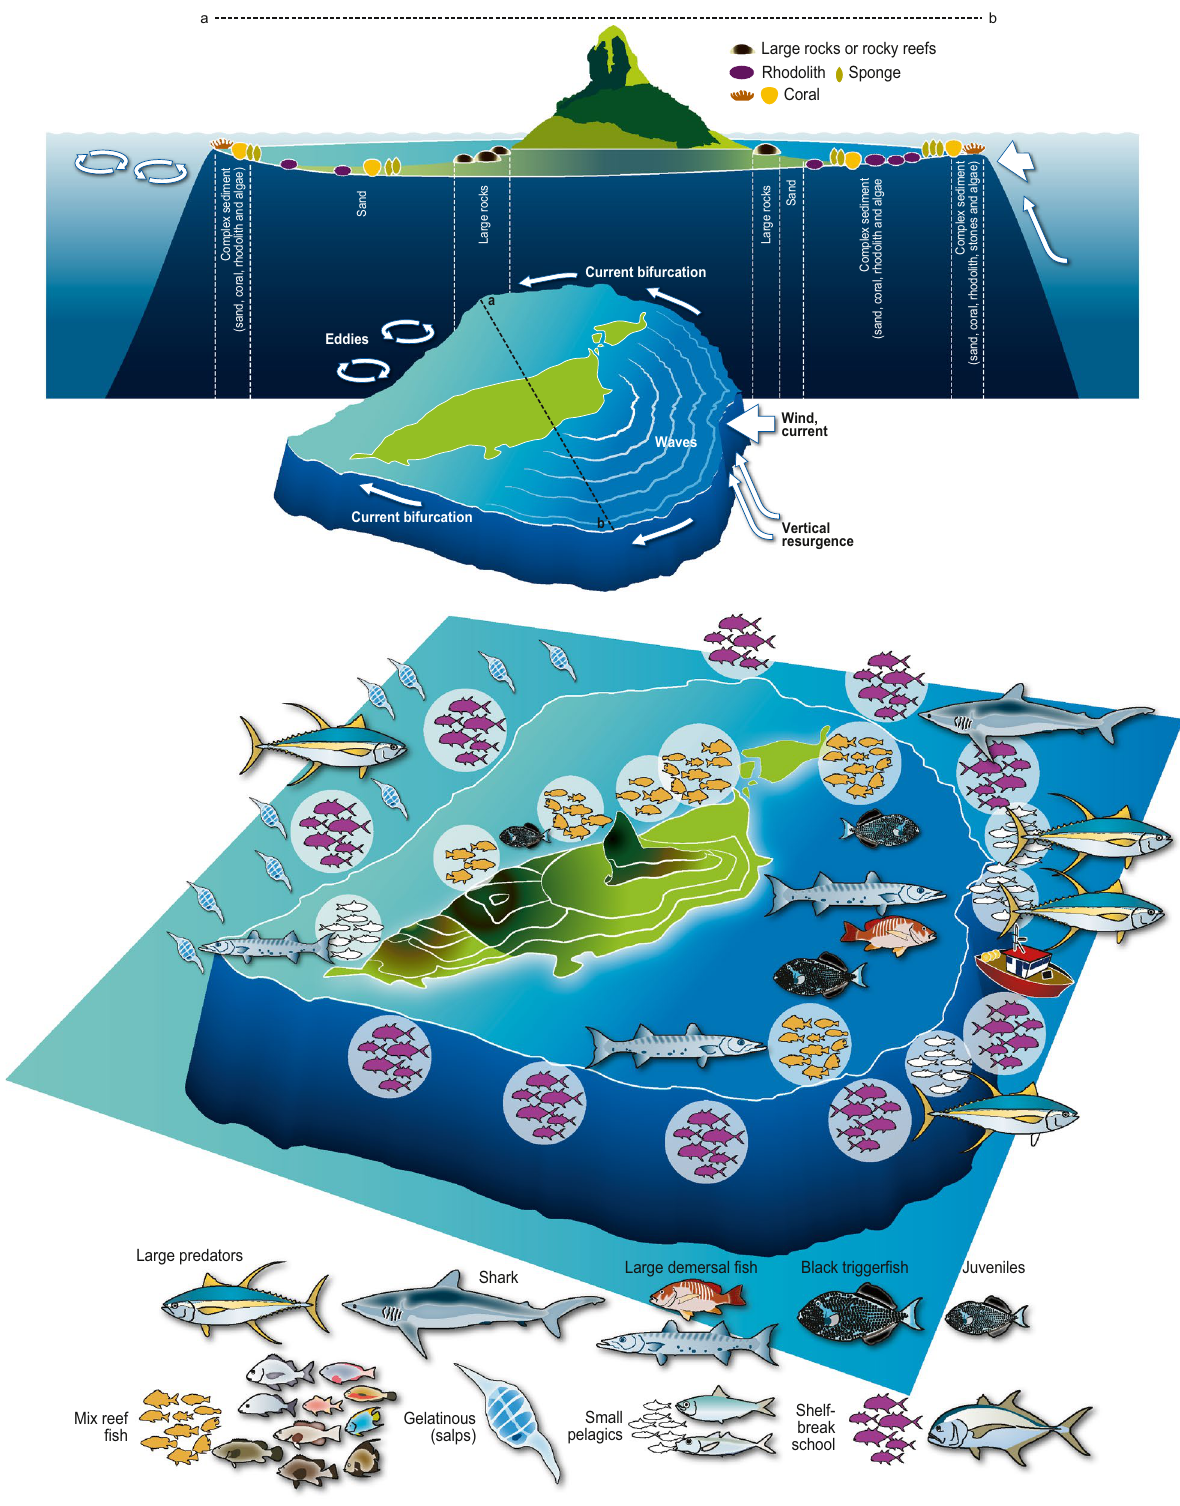
Figure 10. Synthetic representation of the island mass effect as illustrated by the case of Fernando de